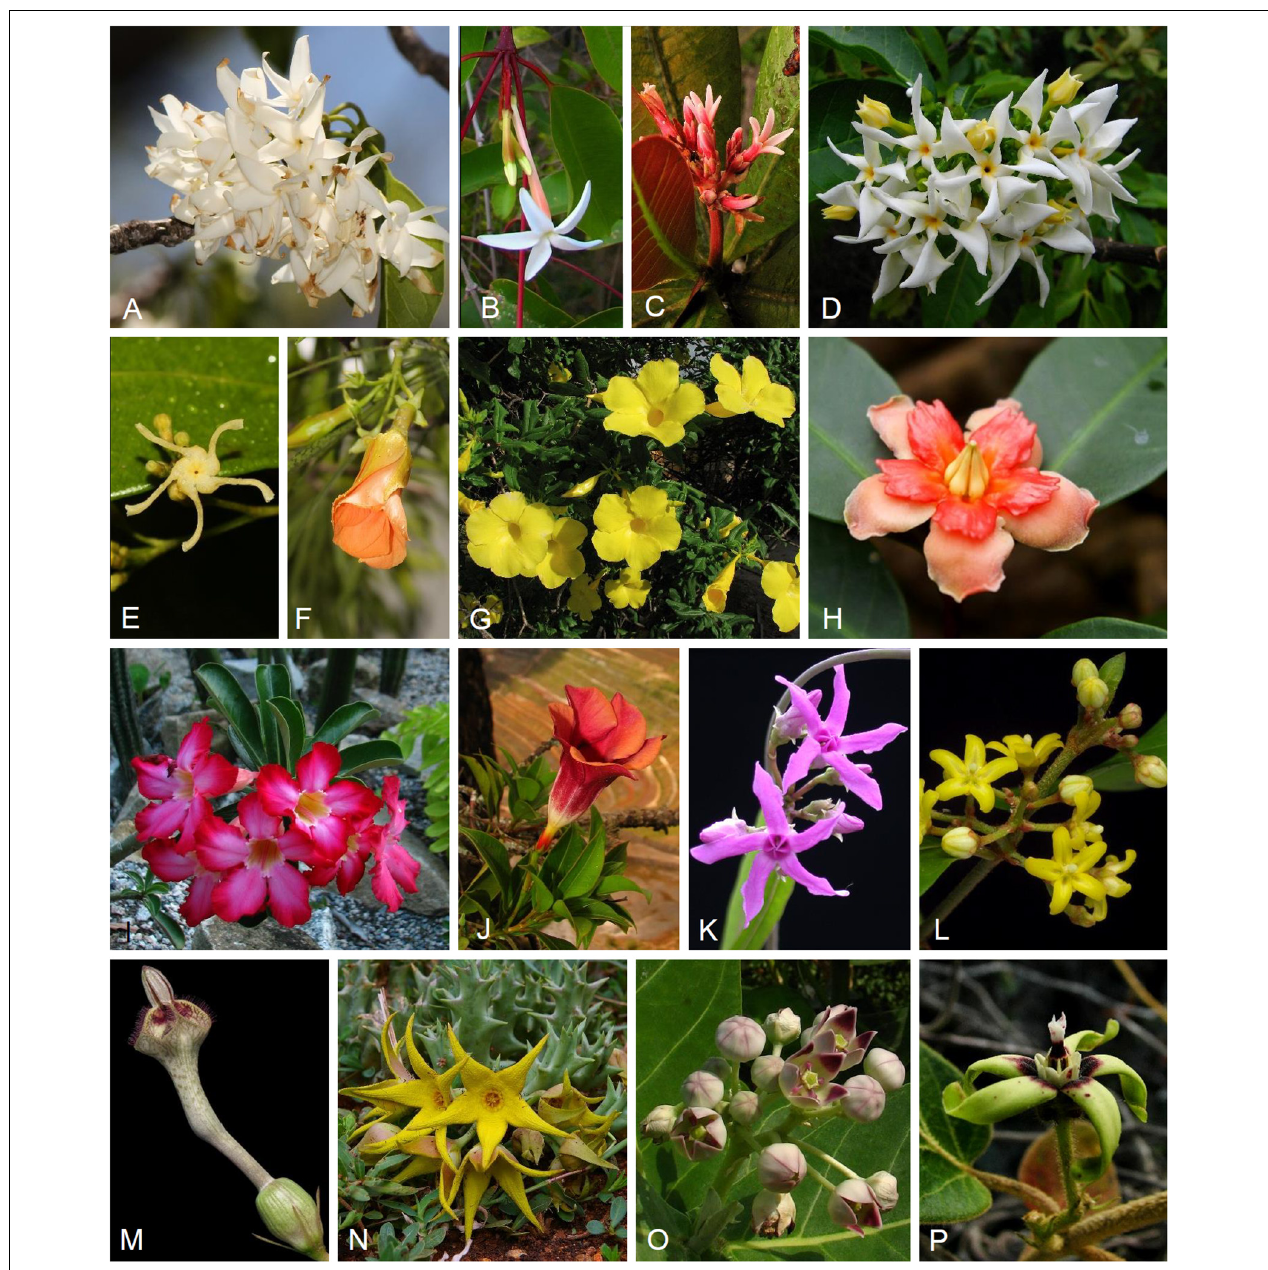
FIGURE 1 | Diversity of flowers in Apocynaceae. (A) Aspidosperma pyrifolium , Aspidospermateae; (B) Hancornia specios a, Willughbeieae; (C) Couma rigida , Willughbeieae; (D) Tabernaemontana solanifolia , Tabernaemontaneae; (E) Condylocarpon isthmicum , Alyxieae; (F) Thevetia peruviana , Plumerieae; (G) Allamanda puberula , Plumerieae, (H) Wrightia coccinea , Wrightieae; (I) Adenium obesum , Nerieae; (J) Mandevilla atroviolacea , Mesechiteae; (K) Pentopetia grevei , Periplocoideae; (L) Secamone parviflora , Secamonoideae; (M) Ceropegia tihamana , Ceropegieae; (N) Orbea lutea , Ceropegieae; (O) Calotropis procera , Asclepiadinae; (P) Oxypetalum rusticum , Oxypetalinae [Photos of panels (A–G,I,J,O,P) by Rapini; panels (H,K–N) by Meve].